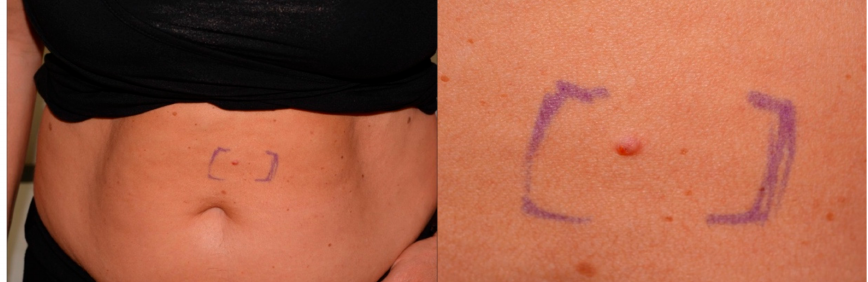
Figure 1. Abdominal sebaceoma patient 2. Faintly pinkish to skin-colored papule with dermoscopi- cally yellowish ovoid areas and arborizing vessels.